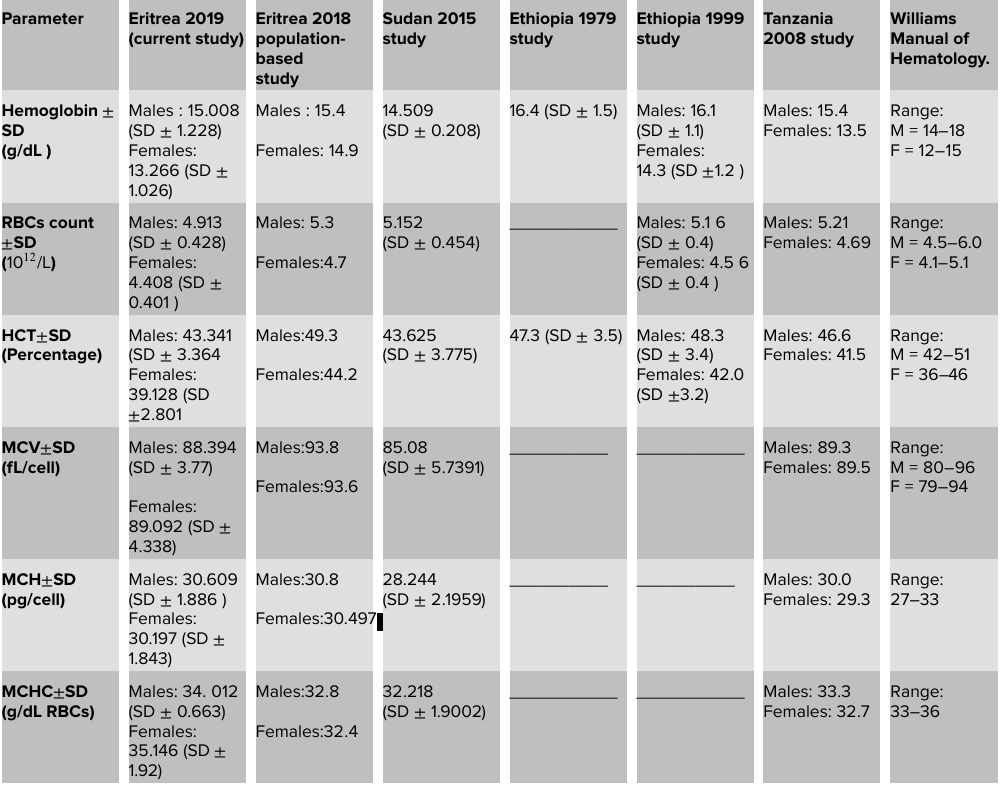
TABLE 4: Comparison between the studies done in healthy population within Sudan, Eritrea, Tanzania, and Ethiopia with regards tohemoglobin, RBCs count, and RBCs indices. Parameter Eritrea 2019 Eritrea 2018 Sudan 2015 Ethiopia 1979 Ethiopia 1999 Tanzania Williams (current study) population- study study study 2008 study Manual of based study